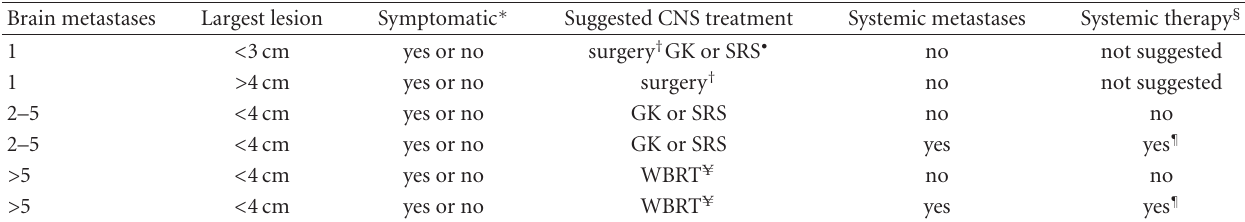
Table 1: Potential management strategies for melanoma patients with brain